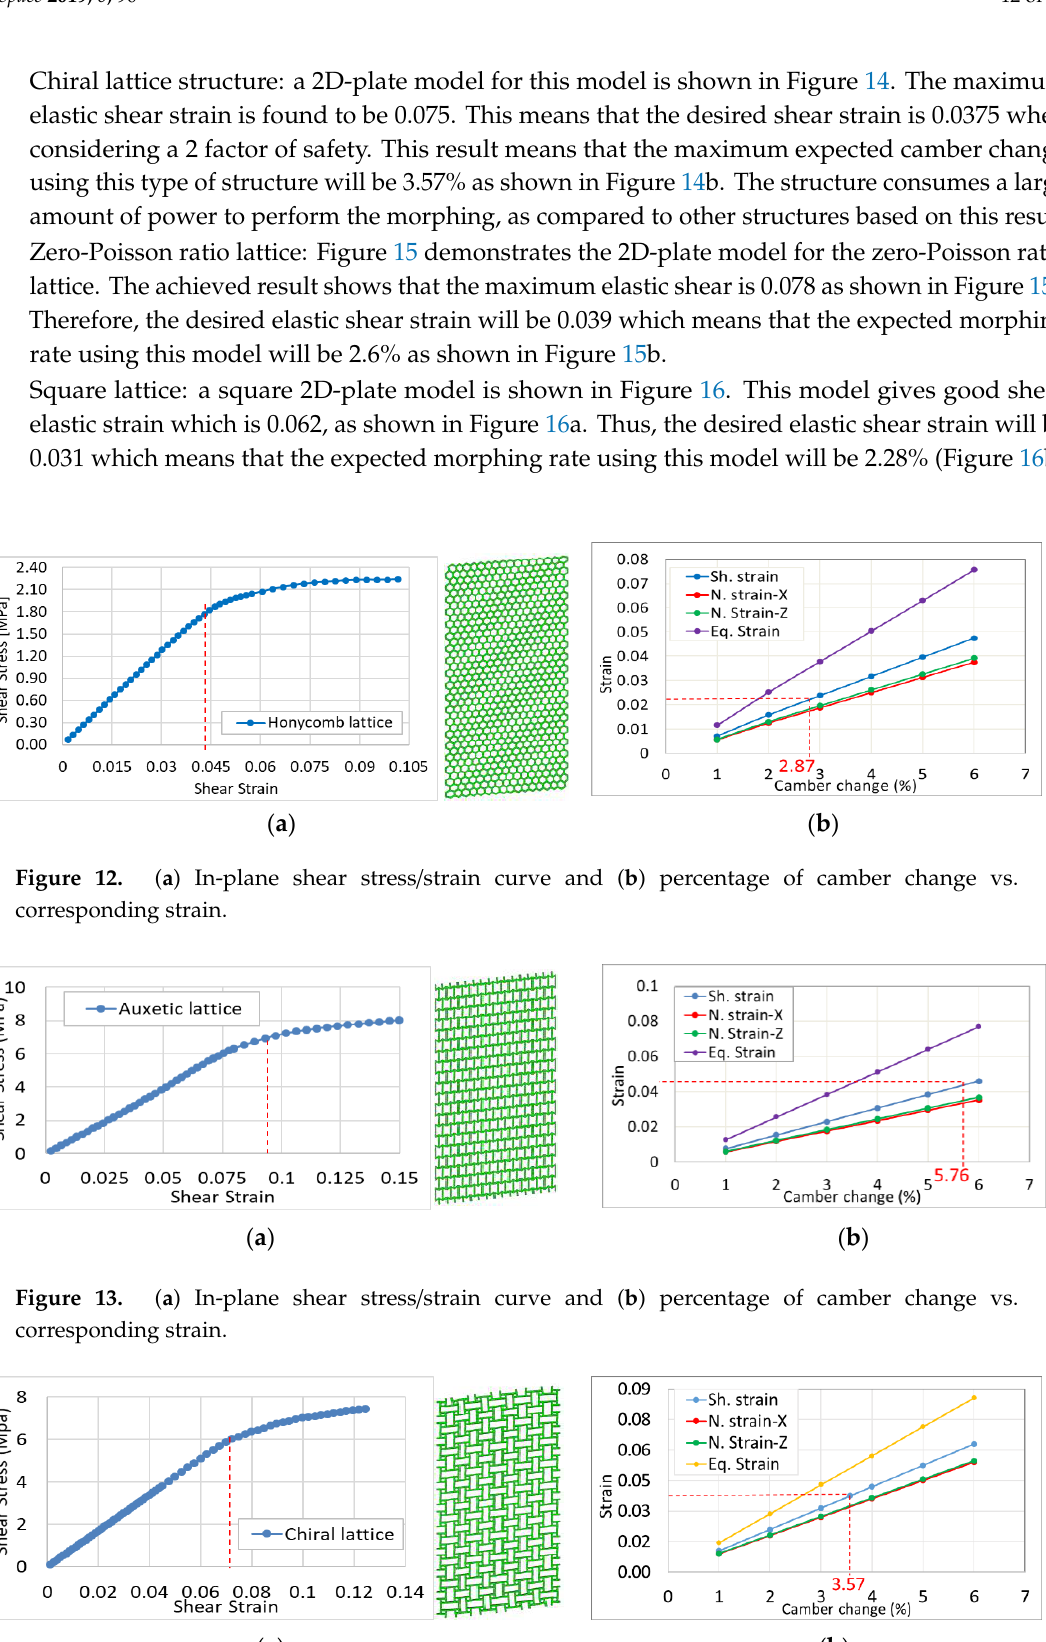
Figure 14. ( a ) In-plane shear stress/strain curve and ( b ) percentage of camber change vs. corresponding strain.